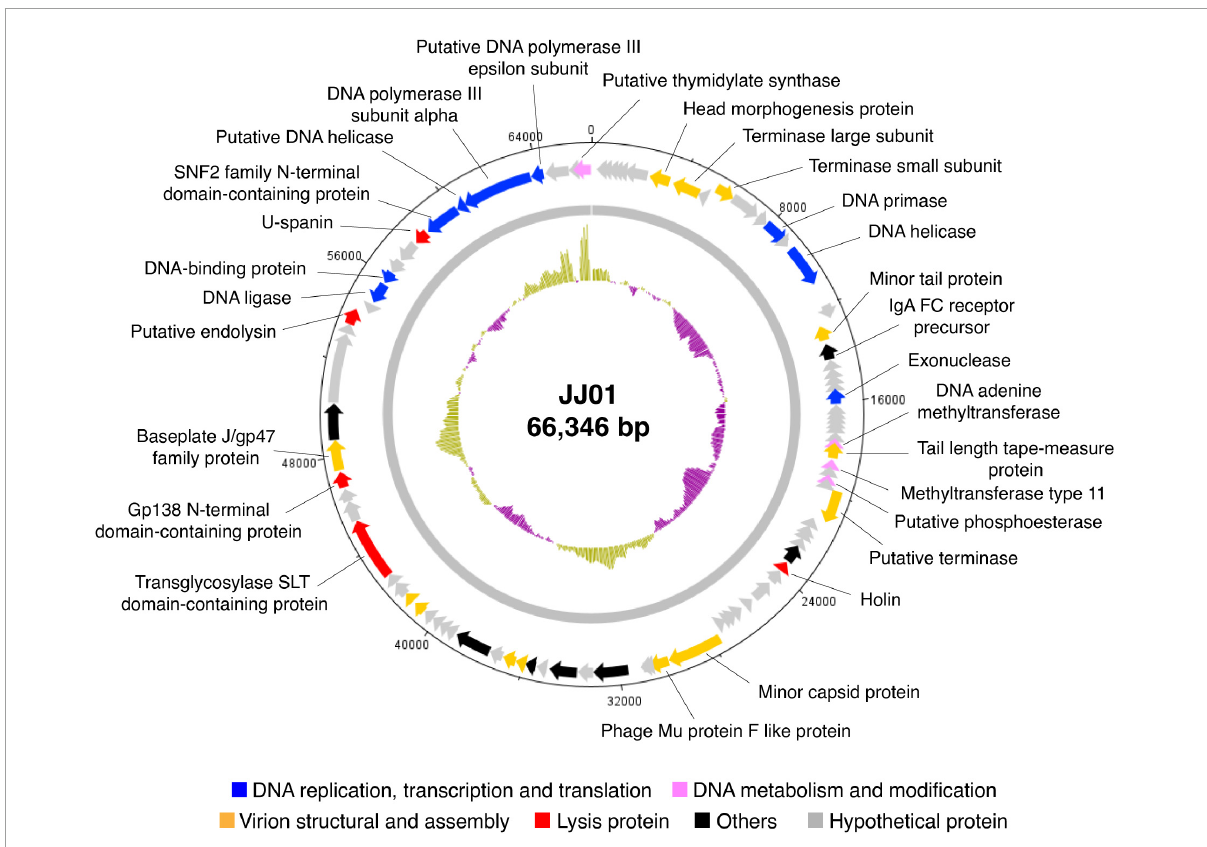
FIGURE2 Circular genomic map of phage JJ01. The genome size is 66,346 base pairs, composed of 92 ORFs which are functionally annotated and are divided into different groups as indicated by colors as follows: blue, DNA replication and transcription, and translation; pink, DNA metabolism and modification; orange, virion structural and assembly; red, lysis protein; black, others; and gray, hypothetical proteins. An inner plot presents the GC content across the genome (yellow above average and purple below average). The direction of arrows indicates gene arrangement in the JJ01 genome. The map was generated using Artemis: DNAPlotter version